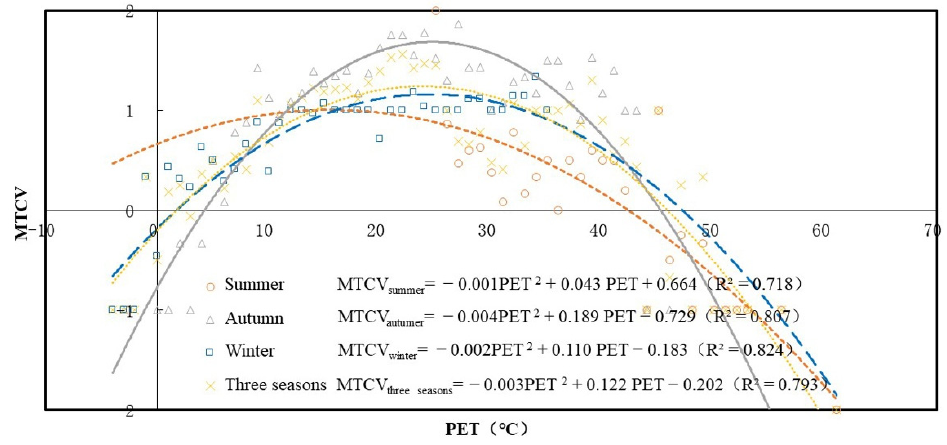
Figure 6. The relationships between MTCV and PET in summer, autumn, winter, and three seasons. The thermal comfort range is defined as the PET value corresponding to TCV greater than 0.5 in the current study. Accordingly, the thermal comfort ranges were 10.3~32.7 ◦ C in summer, 12.4~34.8 ◦ C in autumn, 14.7~40.3 ◦ C in winter, and 6.9~33.7 ◦ C across all seasons. As shown in Table 3, the thermal comfort ranges in summer, autumn, winter, and all seasons were much wider than the thermal neutral ranges. The upper limit of thermal comfort was higher than that of thermal